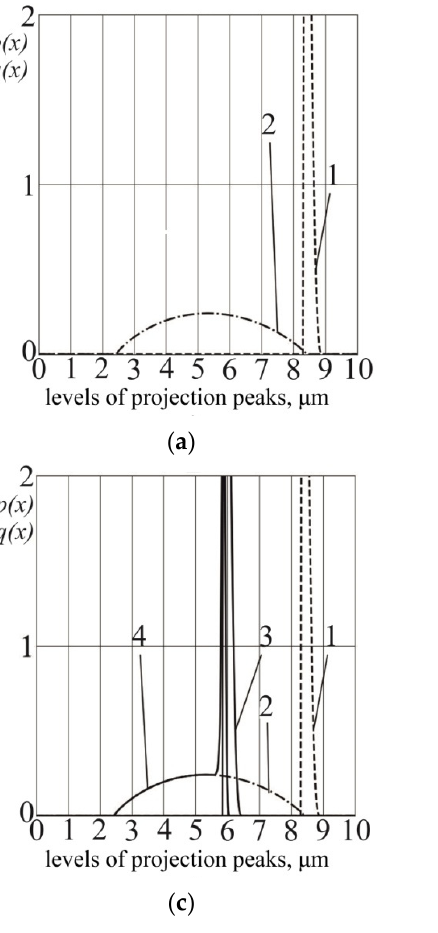
Figure 2. The distribution of heights ( a ) the initial density distribution, ( b ) after running, ( c ) friction way L = 240 km, ( d ) friction way L = 1200 km (the moment of the end of the work): 1—initial q 0 ( x ) (crankshaft journal); 2—initial p 0 ( x ) (half-bearing); 3—current q ( x ) ; 4—current p ( x )